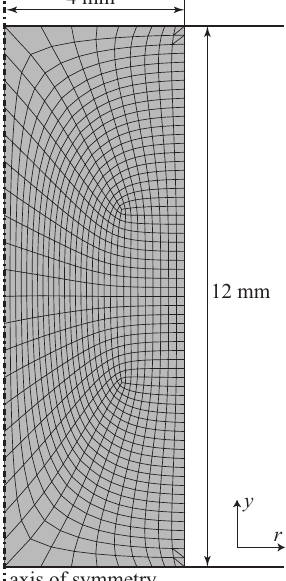
Figure 2. Finite element model of the compression